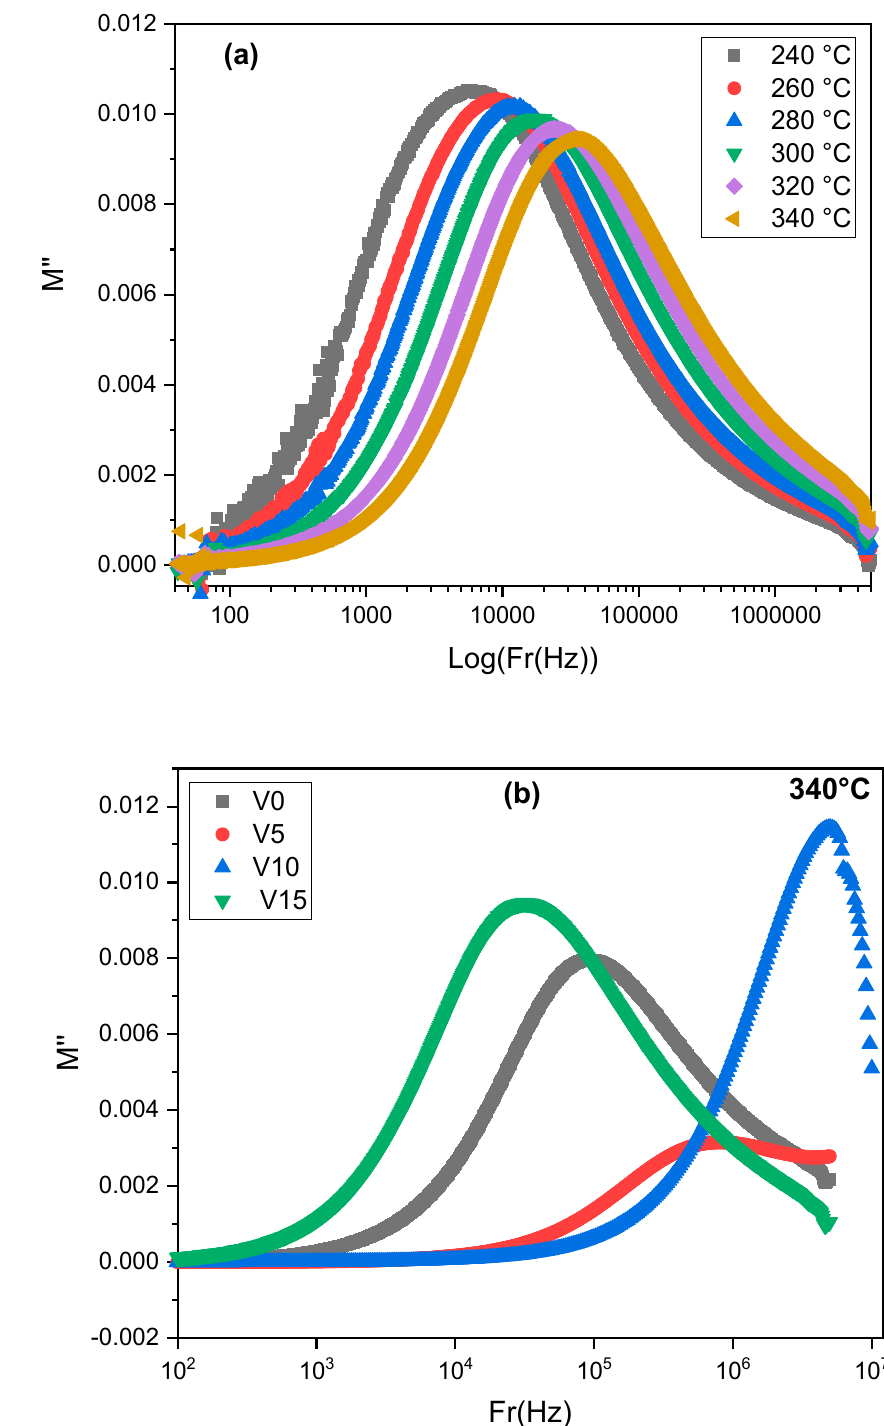
Figure 14. The frequency dependence of M” for ( a ) TZV15 at different temperatures ( b ) of different glass samples at T = 340 °C.